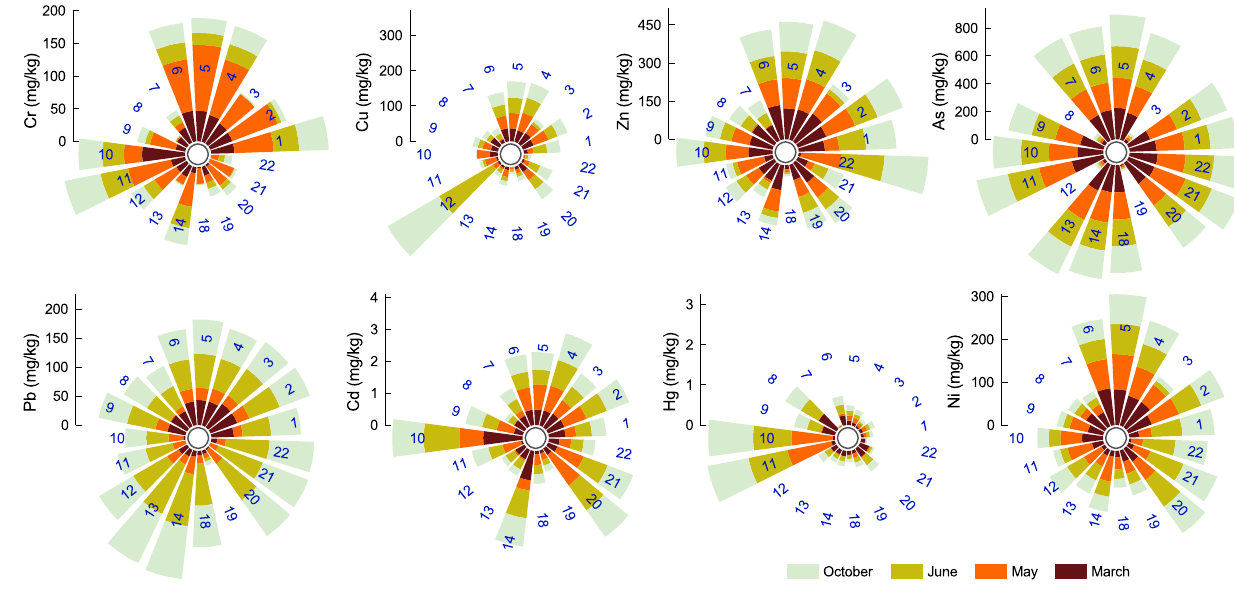
Figure 1. Spatial–temporal distribution of heavy metals contamination level in the 2018 Olt River